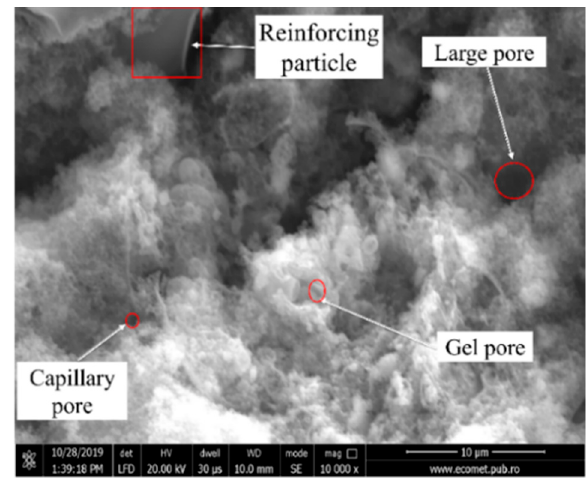
Figure 4. Coal-ash based geopolymers morphology.